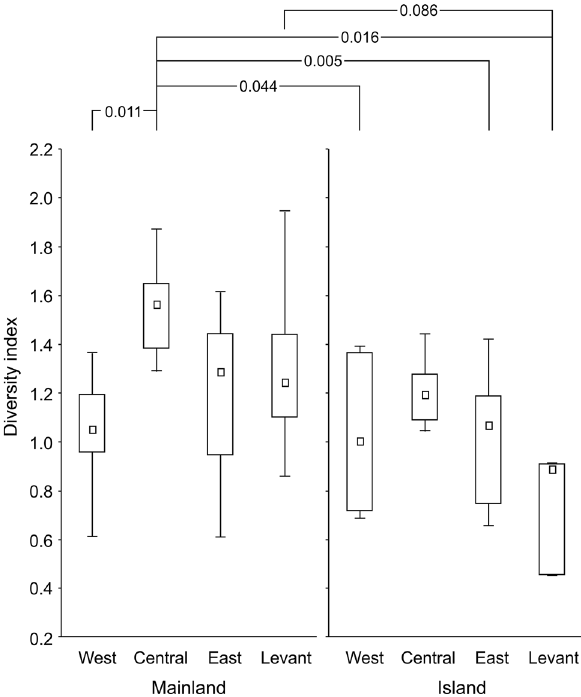
Figure 2. The differences in mammalian prey diet diversity on mainland and island localities regarding to four subregions of the Mediterranean. The numbers above the graph refer to statistical significances and marginal statistical significances (P-values) based on post-hoc tests. Squares—medians, boxes—25–75% of data, whiskers—non-outlier ranges.